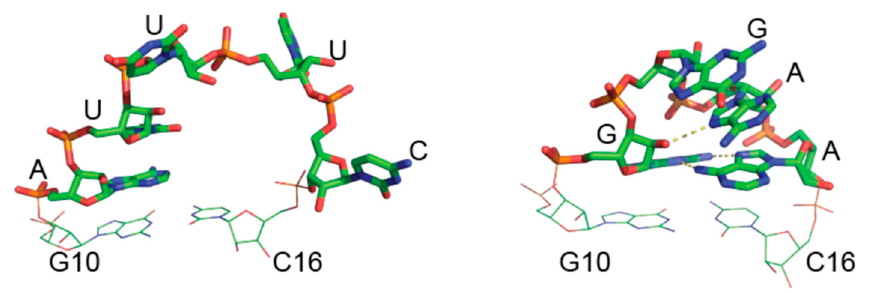
Figure 8. Structure of DsrA SL1 WT pentaloop ( left ) vs. mutated tetraloop ( right ). Note that G10 and C16 refers as WT DsrA SL1 numbering but should be 15 for the tetraloop.